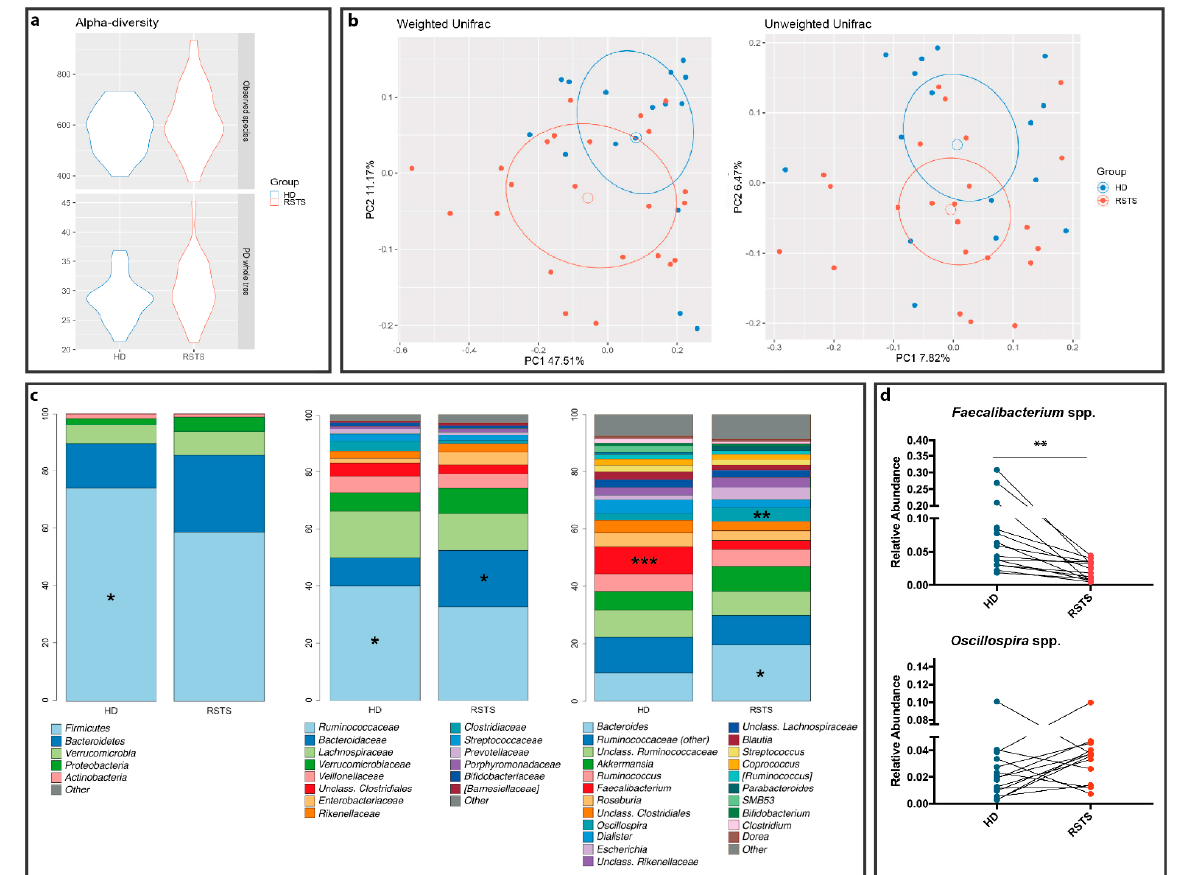
Figure 2. RSTS gut microbiota analysis. ( a ) alpha diversity. The violin plot shows biodiversity values for observed species and Faith’s phylogenetic metrics. No statistically relevant differences were seen. ( b ) Principal coordinate analysis (PCoA) according to weighted and unweighted Unifrac distances. Microbial communities are statistically different ( Adonis test: unweighted p = 0.019; weighted p = 0.023). The first and second principal coordinates are shown in the plot for both distances. ( c ) Bacterial composition of HD and RSTS groups. Relative taxonomic abundances are shown at phylum, family, and genus phylogenetic levels. All bacterial taxa present at <1% relative abundance were grouped into the “Other” classification. ***: p < 0.005; **: p < 0.01; *: p < 0.05. ( d ) Faecalibacterium spp. and Oscillospira spp. relative abundances (both significantly different between RSTS and HD) were compared within matched family members (patient/sibling, n = 16). For Oscillospira we did not observe a common pattern; Faecalibacterium spp. was significantly reduced in RSTS ( p = 0.0021, Wilcoxon signed-rank